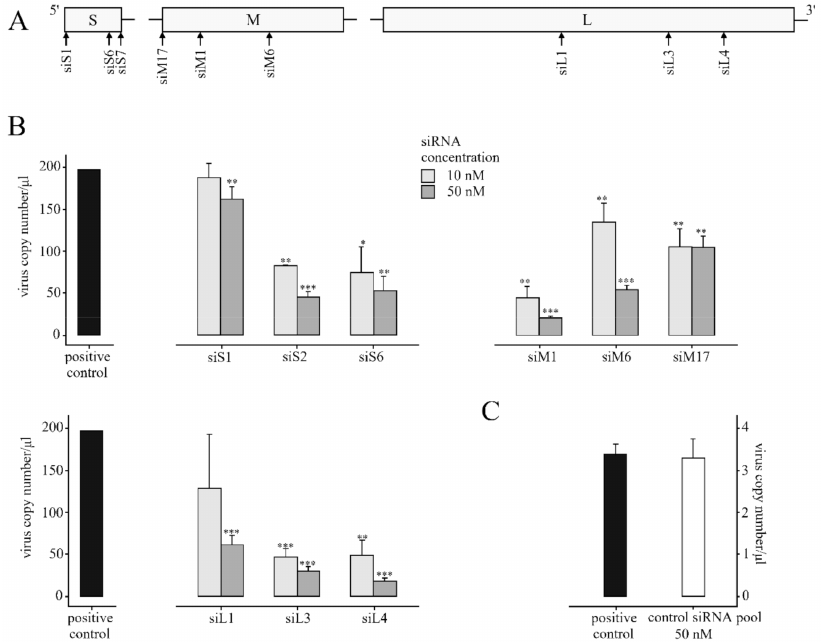
Figure 2. A549 cells were transfected with siRNAs, which were designed for Crimean-Congo hemorrhagic fever virus (CCHFV) S, M, and L segments in di ff erent concentrations (10 nM, 50 nM). After transfection, cells were infected with CCHFV at a MOI of 0.1. Three biological replicates of siRNA inhibited CCHFV samples were used and the positive control was used in three biological and three technical repeats. The virus copy number was determined after 72 h by RT-ddPCR. ( A ) CCHFV schematic gene map containing the designed CCHFV-specific siRNAs site; ( B ) inhibitory e ff ect of siRNAs against CCHFV: the horizontal axis represents the virus copy number / µ L and the vertical axis represents the positive control and designed siRNAs. Student’s t -tests were significant if *: p < 0.05, **: p < 0.01, ***: p < 0.001. Error bars represent the standard deviation (SD) of the means for three independent experiments. ( C ) Positive control and ON-TARGET plus non-target siRNA pool comparison: there is no significant di ff erence between them by Student’s t -tests. The horizontal axis represents the virus copy number / µ L and the vertical axis represents the positive control and non-targeting control siRNA pool. Error bars represent the standard deviation (SD) of the means for three independent